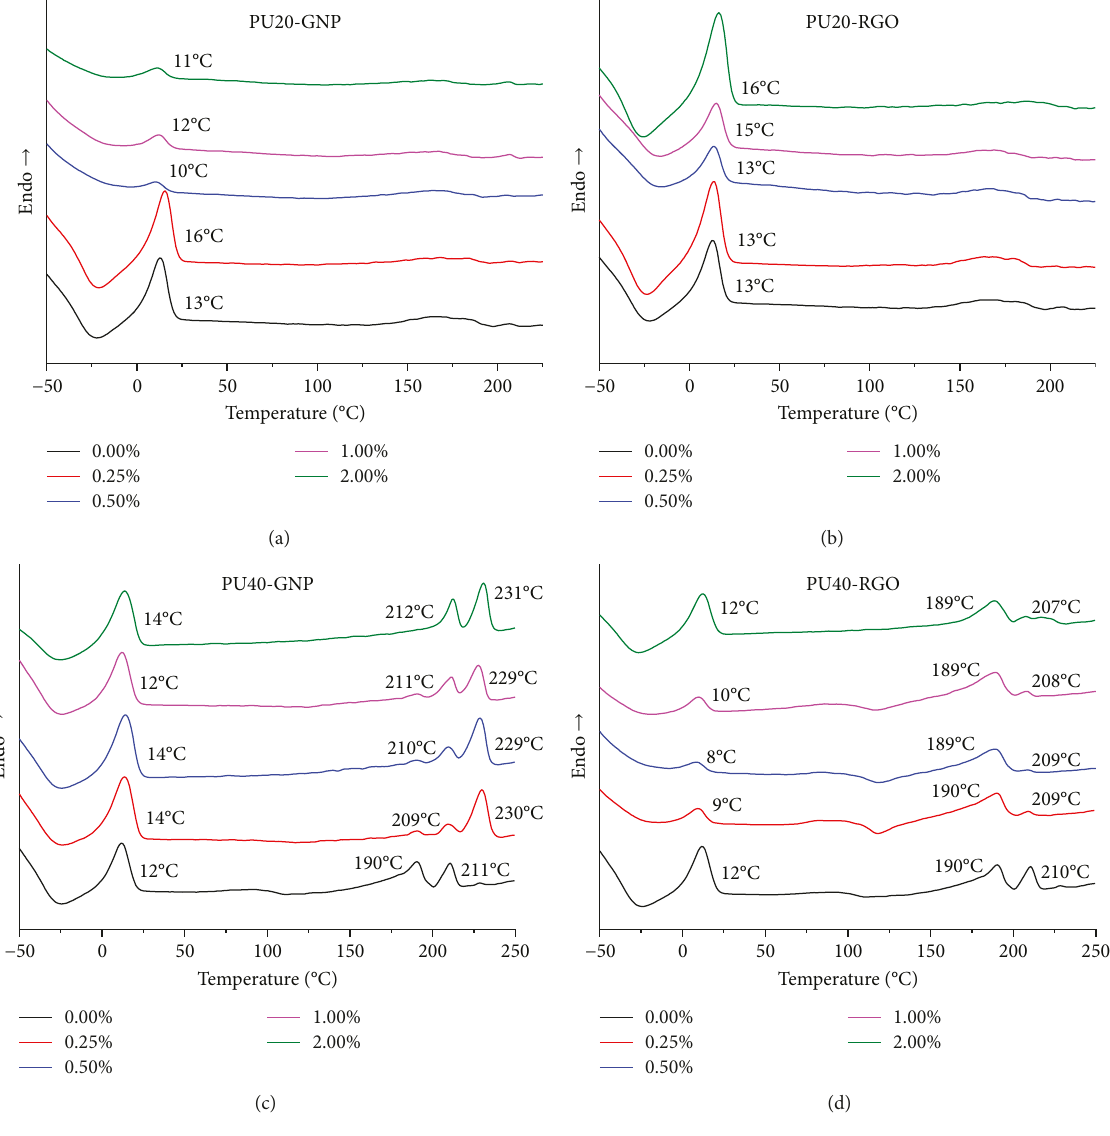
Figure 12: DSC thermograms for PU nanocomposites (heating scans). Table 2: Enthalpy of melting for PU nanocomposites (heating